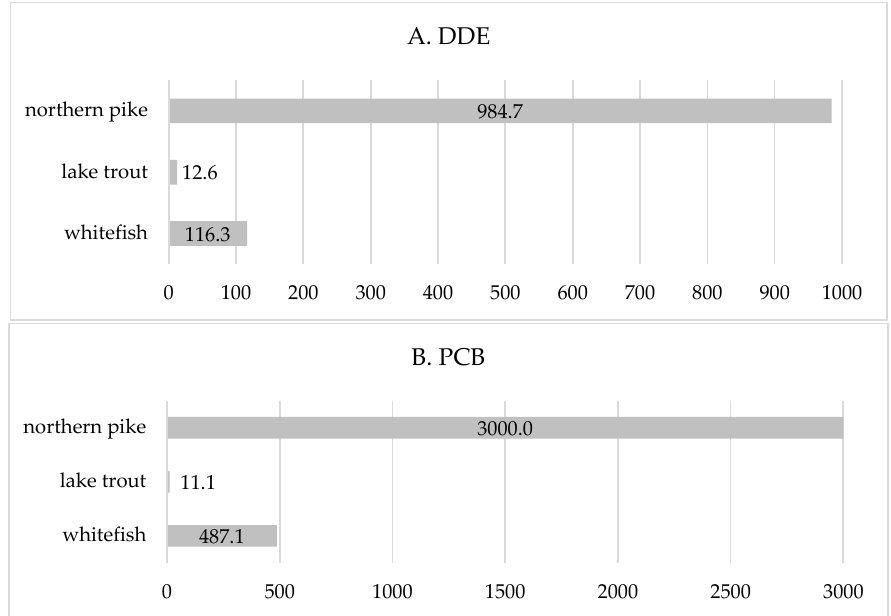
Figure 4. Amount of daily fish intake (g/d) with ( A ) DDE levels and ( B ) PCB levels below the estimated breakpoint in Manitoba. DDE breakpoint = 2.11 ng/kg/day; PCB breakpoint = 1.47 ng/kg/day; reference body weight = 70 kg.